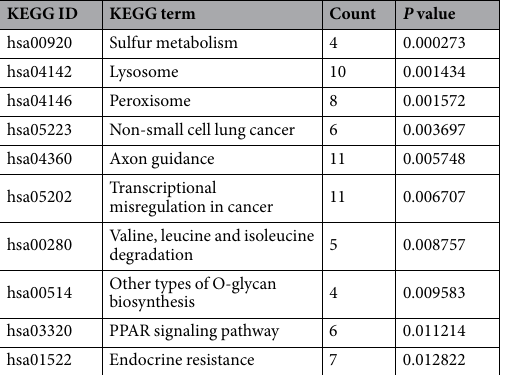
Table 4. KEGG pathway enrichment analysis of the co-expressed genes of HOXA11-AS. Notes: KEGG, Kyoto Encyclopedia of Genes and Genomes.